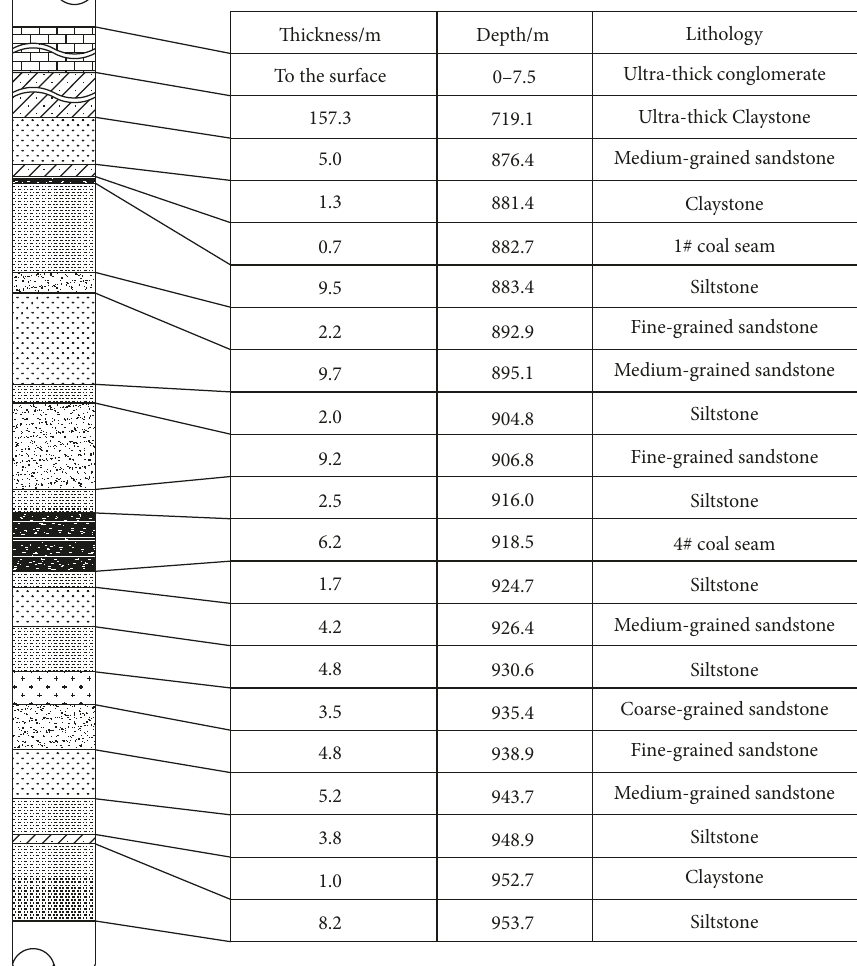
Figure 4: Generalized stratigraphy column of the test